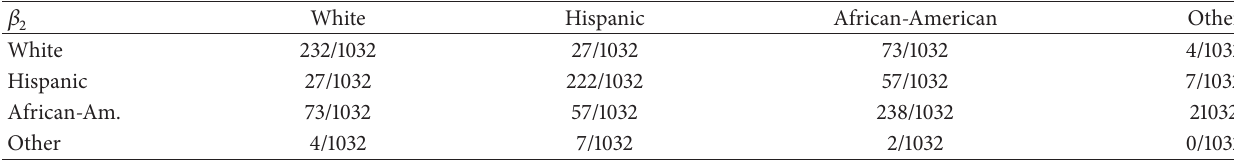
Table 7: Ethnicity bivariate 𝛽 2 .